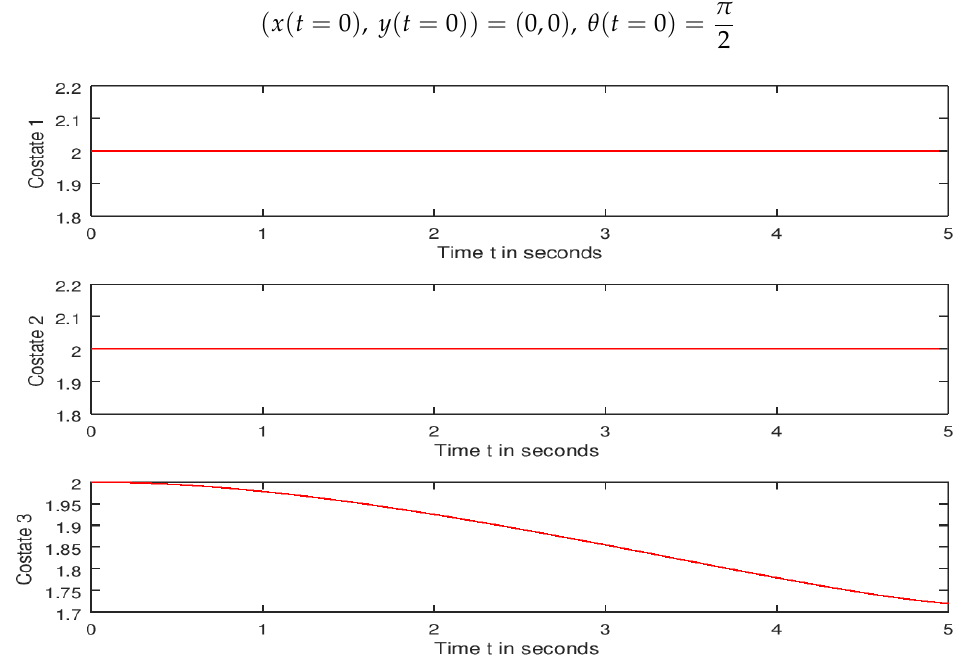
Figure 13. Feasible first three costate trajectories.